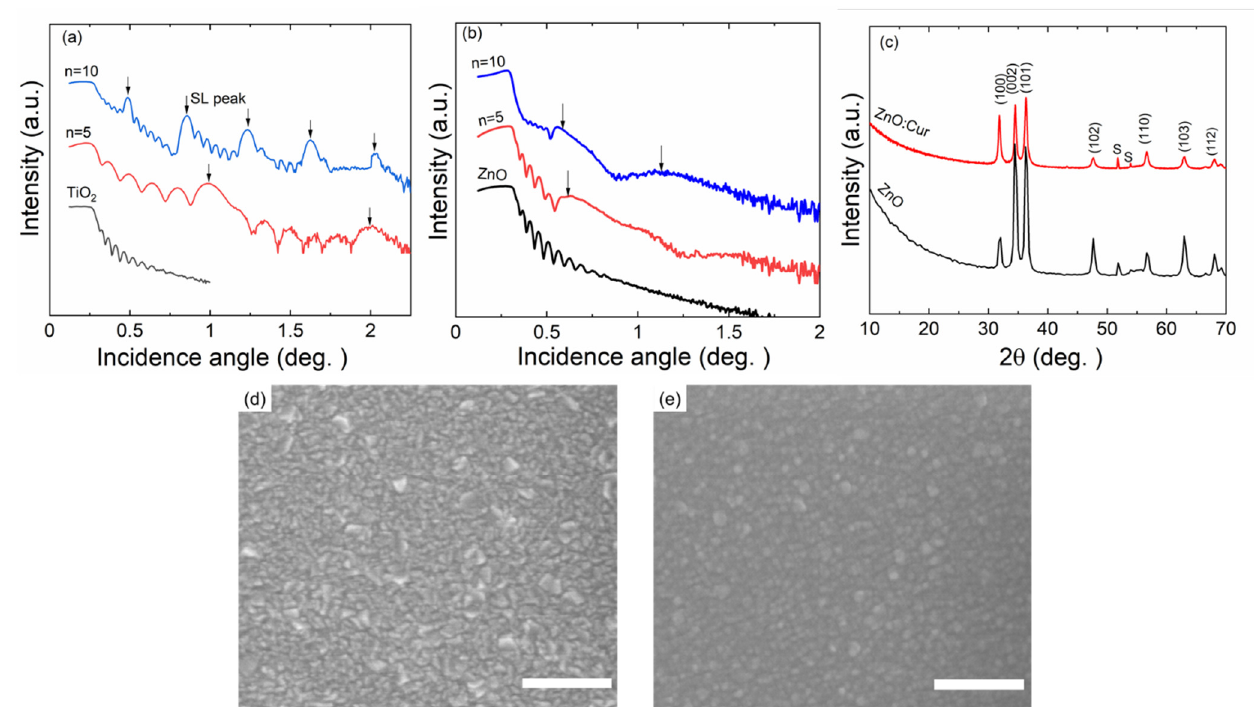
Figure 4. Characterization data for representative metal oxide:Cur SL films grown with ALD/MLD: ( a ) XRR patterns for TiO 2 :Cur films with different n values (=number of Cur layers) [30], SL peaks marked with arrows; ( b ) XRR patterns for ZnO:Cur films with different n values; ( c ) GIXRD patterns of ZnO and ZnO:Cur ( n = 5) films, peaks from silicon substrate marked with s; top-view SEM images for ( d ) ZnO, and ( e ) ZnO:Cur films (scale bars are for 300 nm).